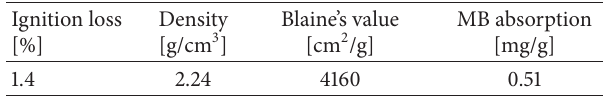
Table 2: Properties of fly ash used.